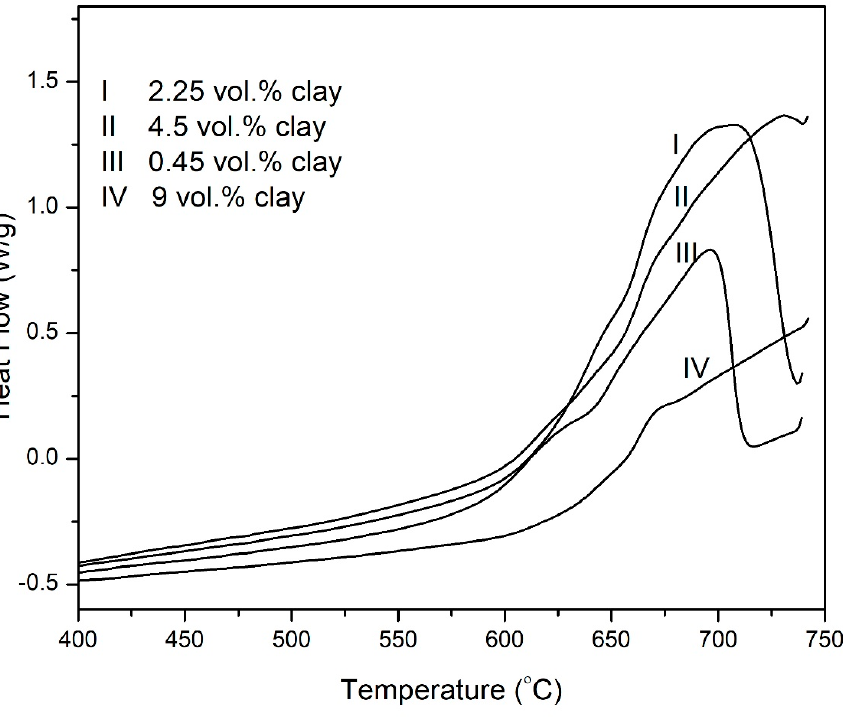
Figure 13. DSC thermograms for the hybrid composites, PI–NGS–Clay, containing, (I) 2.25, (II) 4.5, (III) 0.45, and (IV) 9 vol.% clay in air atmosphere.